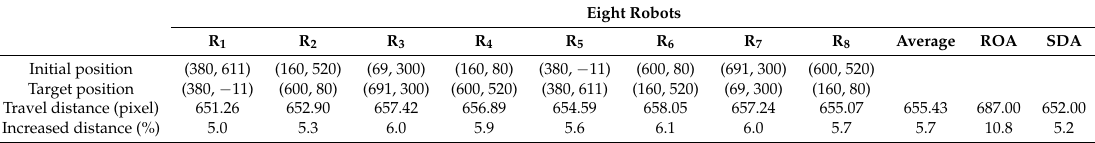
Table 5. Multi-robot navigation performance comparison (two and four robot cases).